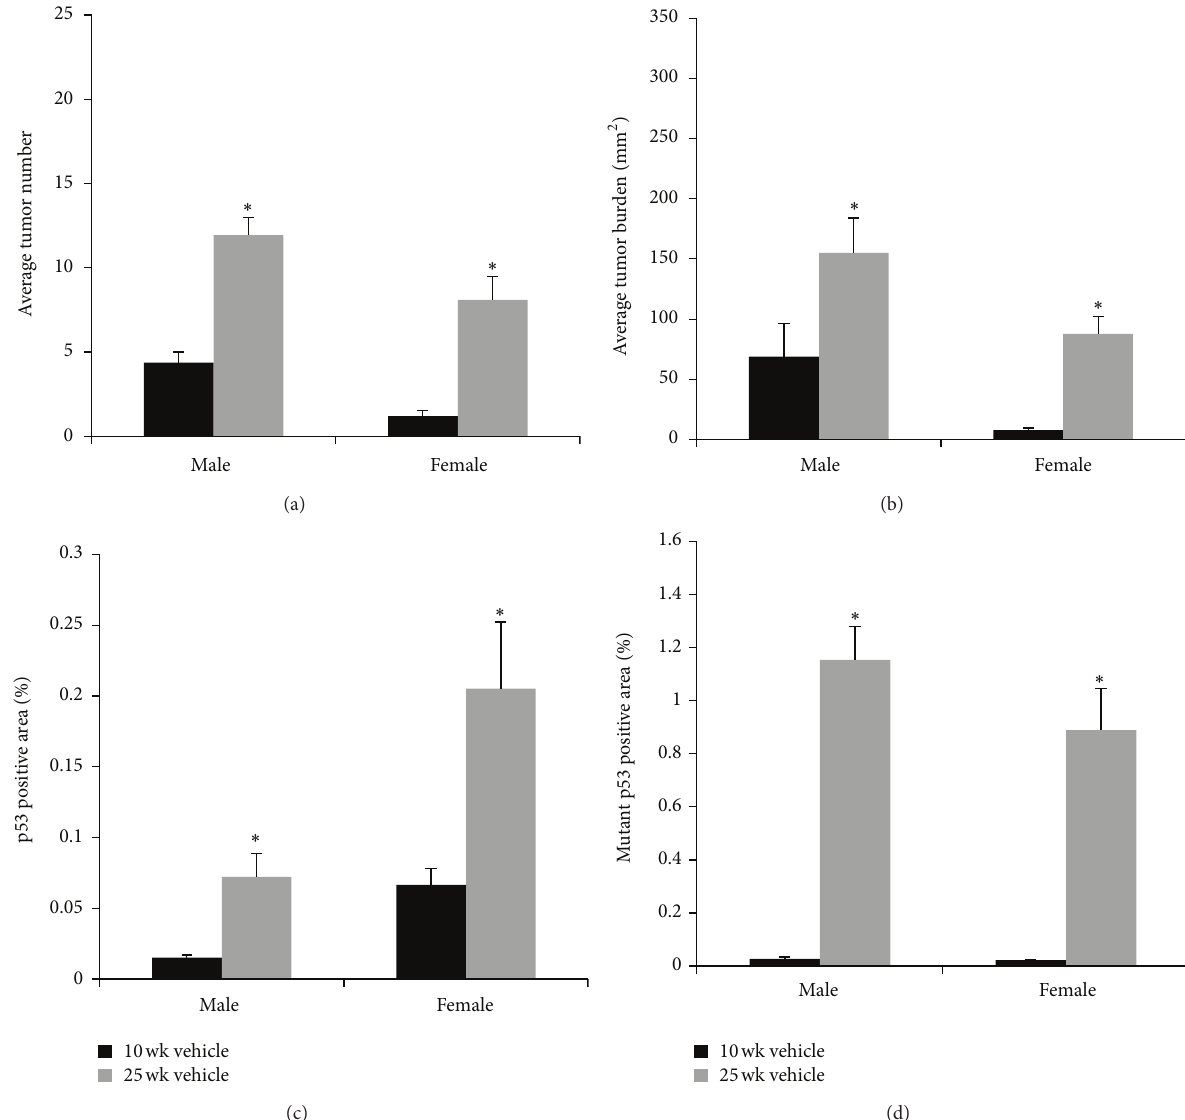
Figure 1: Effect of length of UVB treatments on tumor number, tumor burden, and p53 status in male and female mice. (a) Vehicle-treated male and female mice developed more tumors in the 25-week exposure model ( ∗ 𝑃 < 0.0001 ) compared to the 10-week model. (b) Male ( ∗ 𝑃 = 0.0006 ) and female ( ∗ 𝑃 < 0.0001 ) vehicle-treated mice in the 25-week exposure model exhibited increased tumor burden compared to the 10-week model. (c) Male ( ∗ 𝑃 = 0.0002 ) and female ( ∗ 𝑃 = 0.011 ) mice treated with vehicle in the 25-week model exhibited elevated epidermal p53 staining compared to the 10-week exposure model. (d) Male and female mice treated with vehicle in the 25-week exposure model exhibited elevated epidermal mutant p53 staining ( ∗ 𝑃 < 0.0001 ) compared to the 10-week UVB model. Error bars = mean+/ −